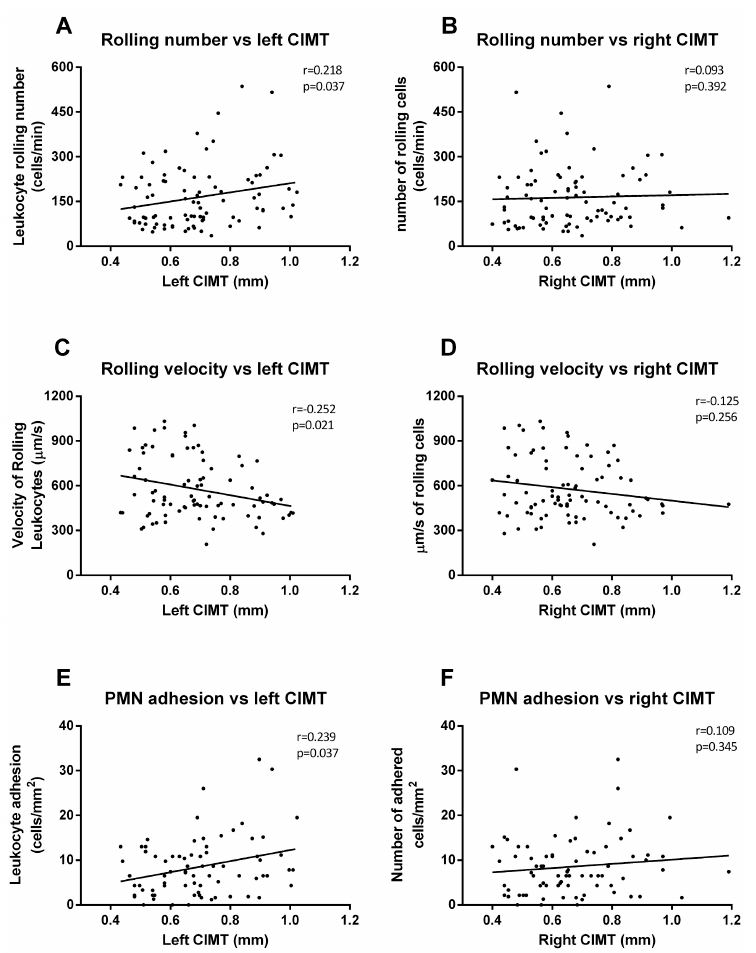
Figure 4. Correlation graphs of adhesion assay vs. CIMT measures . Graphs show correlations between number of rolling PMN and left ( A ) and right CIMT ( B ); rolling velocity and left ( C ) and right CIMT ( D ); and cell adhesion and left ( E ) and right CIMT ( F ). Spearman correlation analysis was performed.